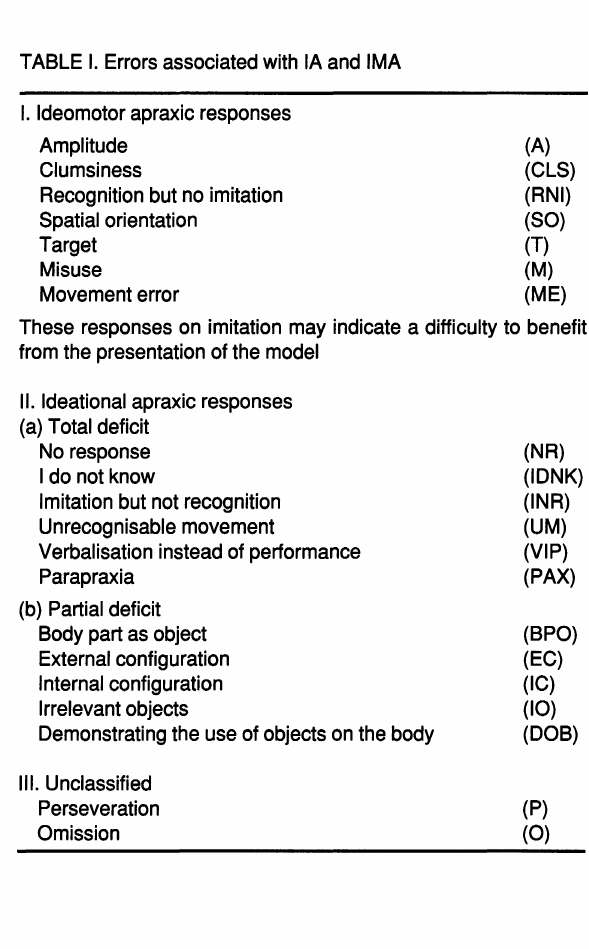
TABLE I. Errors associated with IA and